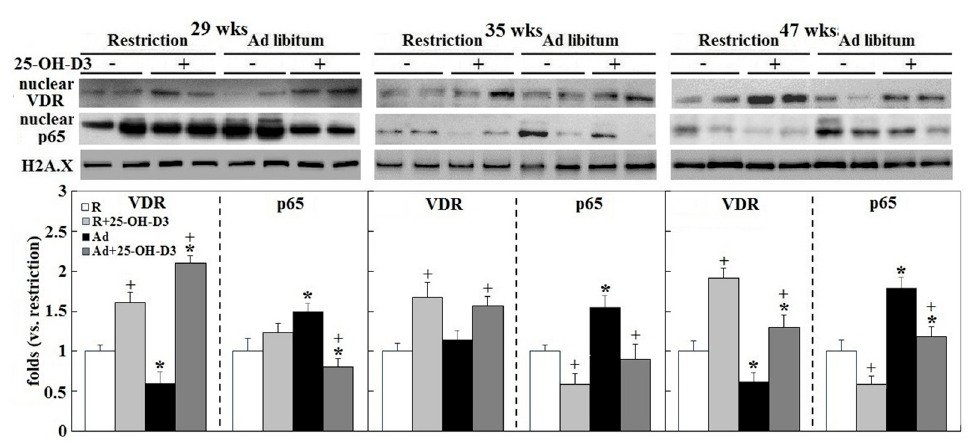
Figure 6. Effects of dietary 25-hydroxycholecalciferol supplementation on cardiac vitamin D receptor (VDR) and nuclear factor- κ B (NF κ B) activation of broiler breeder hens provided with restricted or ad libitum feed intake. Western blots of nuclear VDR and p65 (a subunit of NF κ B; nuclear factor- κ B) were assessed for ( n = 4 for each group). Densitometric intensities results were normalized to histone family member X (H2A.X) and expressed as ratios relative R-hens at 29, 35, or 47 wks. *; significant di ff erence by Ad-feed intake (vs. corresponding R hens, p < 0.05). + ; significant di ff erence by 25-OH-D 3 (vs. R or Ad hens, p < 0.05).